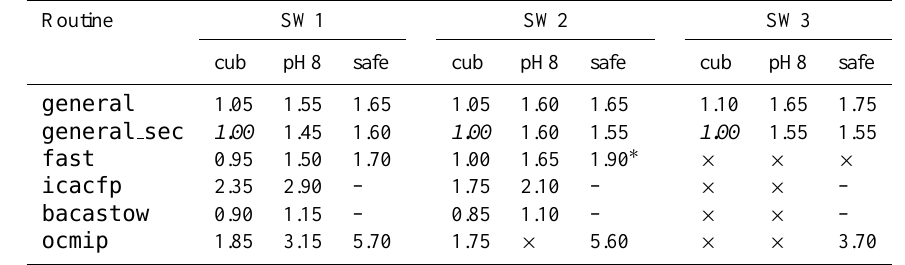
Table 1. Execution times for the SW1, SW2 and SW3 tests, each one with the three initialization types (see text). Crosses ( × ) indicate test series that were affected by divergences and could not be considered for time measurements (notice one exception); dashes (–) indicate that the experiment was not carried out. Within each one of the groups SW1, SW2 and SW3, figures were normalized to the execution time of the respective “cub” run with general sec and rounded to the nearest multiple of 0.05 (i.e. the order of the the largest standard deviation). “cub” results for general sec are reported in italics as they have been implicitly set to exactly 1 by the normalization procedure and are not affected by the rounding